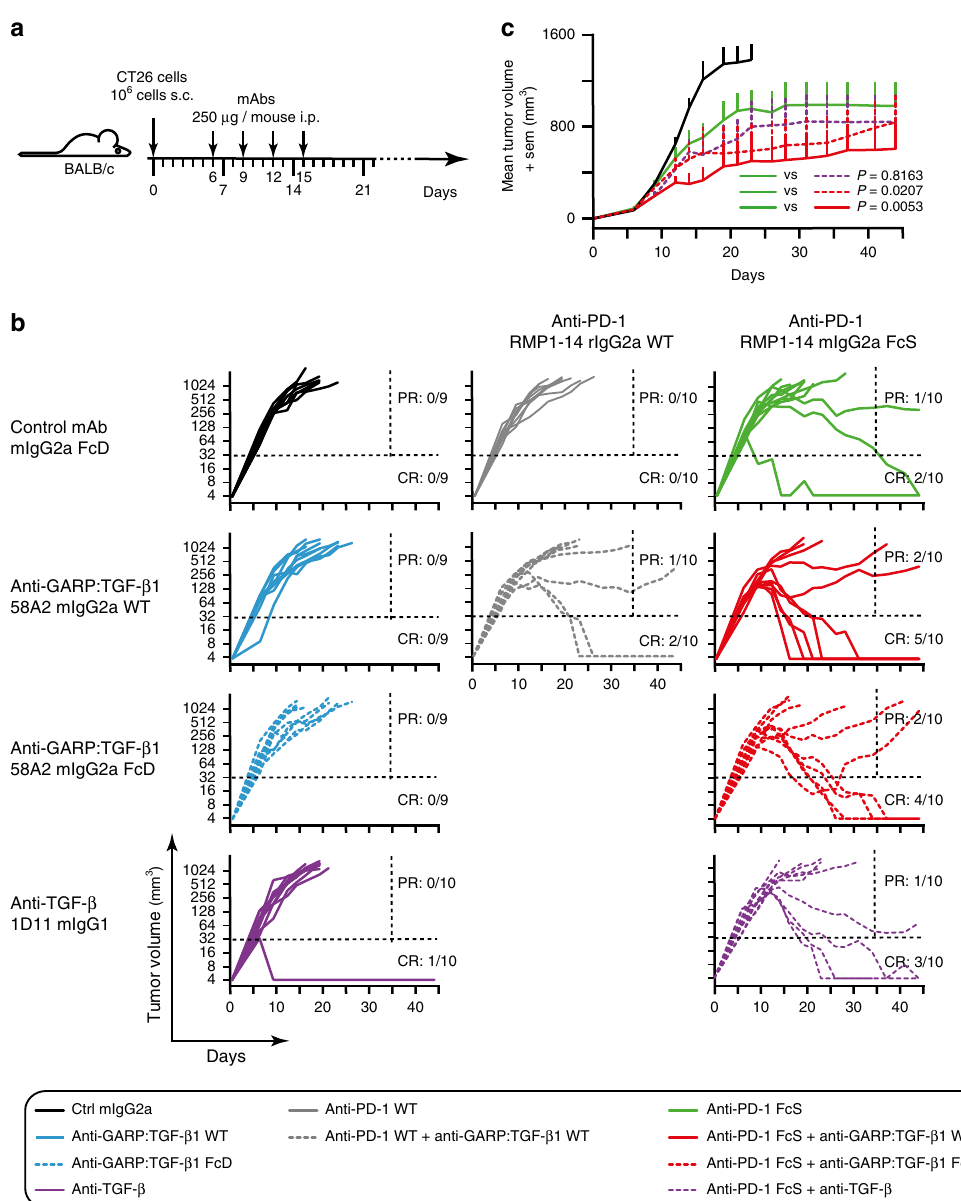
Fig. 2 Combined blockade of GARP:TGF- β 1 and PD-1 shows anti-tumor ef fi cacy. a Schematic representation of the experimental design. BALB/c mice were injected s.c. with live CT26 cells on day 0. Tumor diameters were measured twice a week. Mice were randomized in 10 groups ( n = 9 – 10 mice per group) on day 6, and mAbs were injected i.p. every 3 days from day 6 to 15. Mice were euthanized when the tumor surface was ≥ 200 mm 2 . b Evolution of tumor volumes in the 10 treatment groups (each line represents one mouse). Ratios indicate the proportions of complete responders (CR: mice alive on day 45 with no detectable tumor) and partial responders (PR: mice alive on day 35 that carry a tumor >32 mm 3 at the time of euthanasia). Dotted horizontal and vertical lines indicate the two arbitrary limits (tumor volume of 32 mm 3 and day 35) used to identify PR and CR. c Evolution of mean tumor volumes + sem in fi ve treatment groups. P values for relevant comparisons are indicated and were calculated with a mixed effects model, as recommended for analyses of longitudinal data (Liu et al. 46 ; Sugar et al. 45 ), with a post-hoc Tukey ’ s test for multiple comparisons. Similar results were observed in fi ve other independent experiments (Fig. 3 shows meta-analyses of all pooled